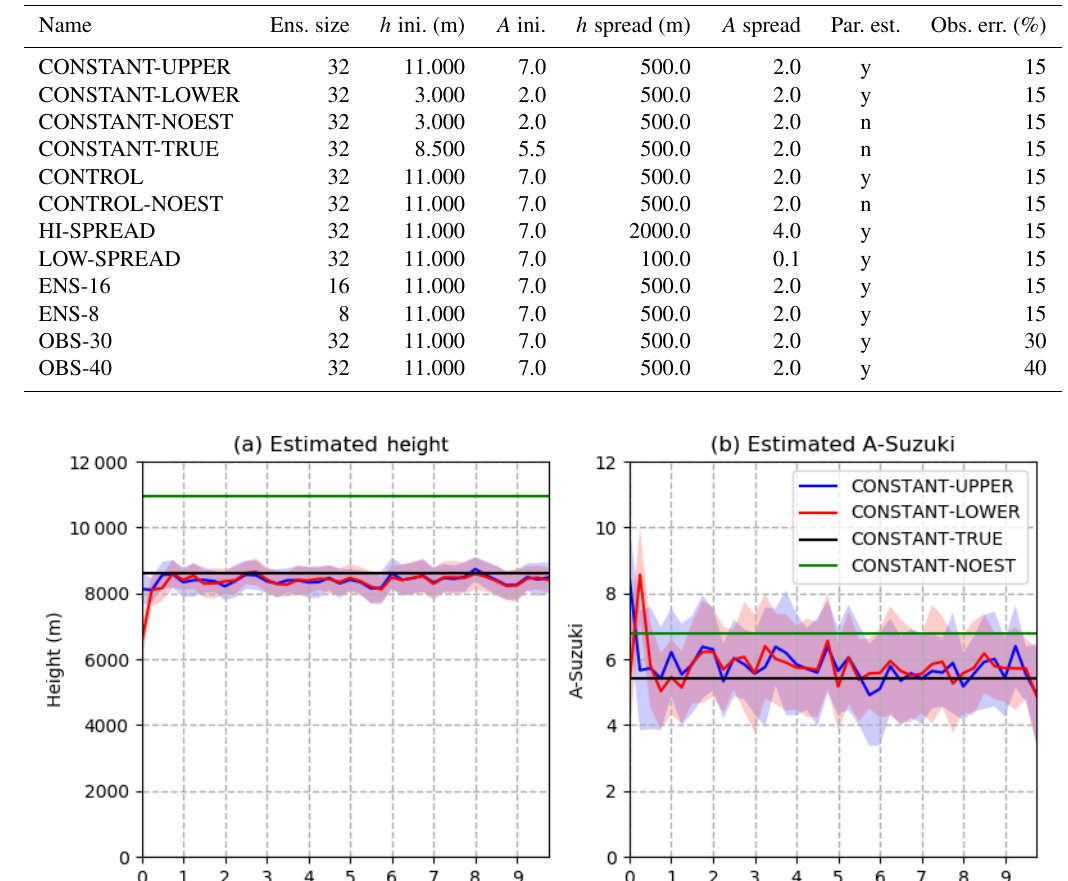
Table 2. Summary of the main parameters that distinguish the different experiments described in the text.